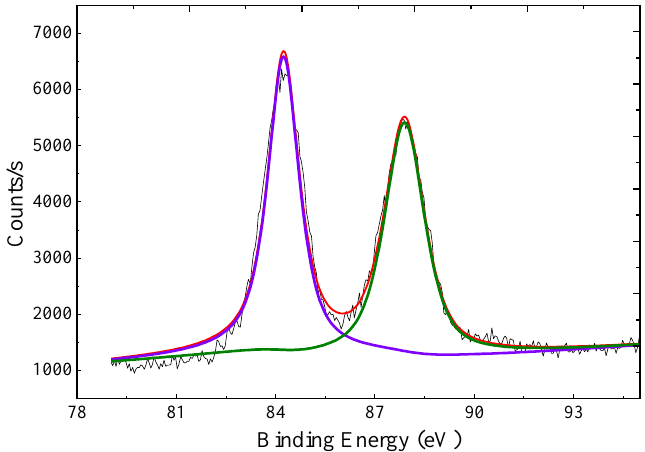
Figure 3. XPS spectra of Au 4 f regions recorded for the nanobiohybrids.